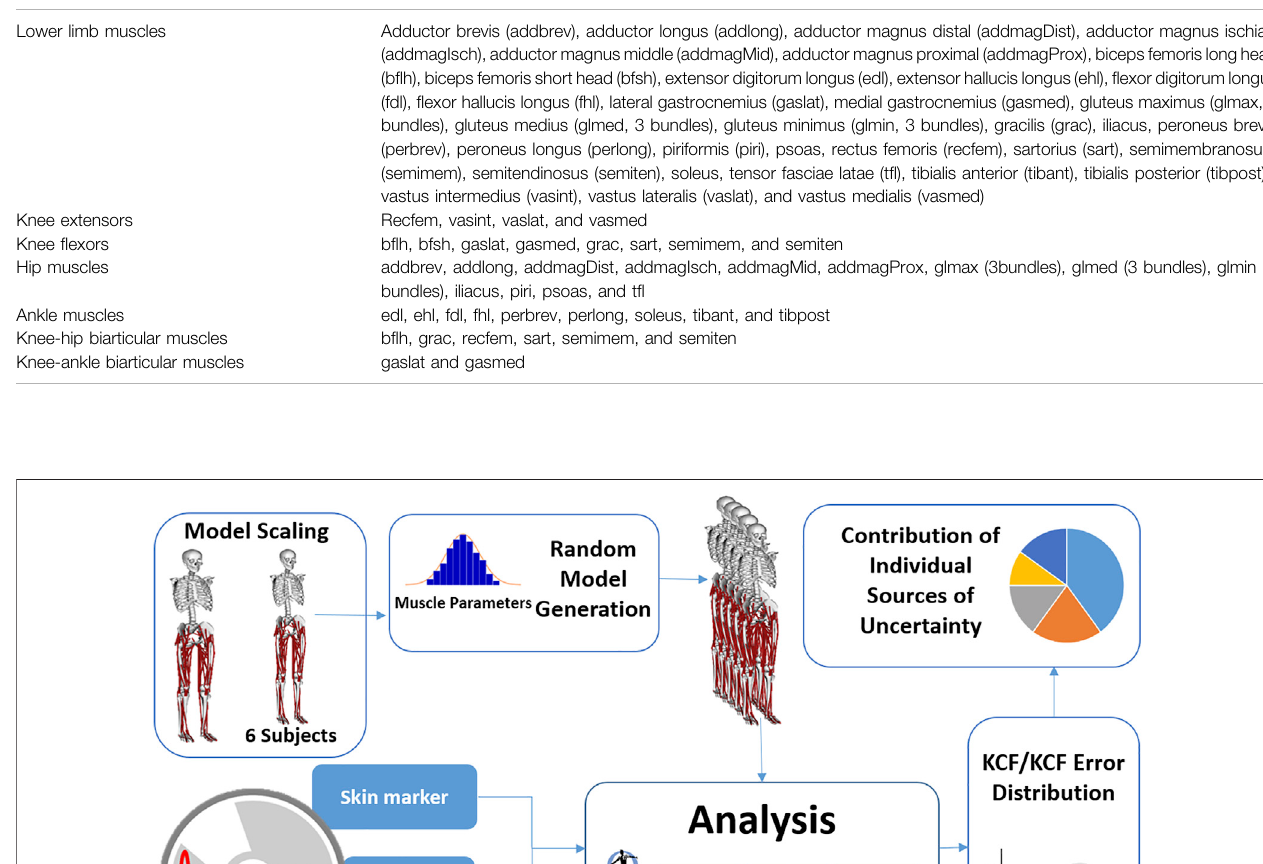
TABLE 1 | Skeletal muscle groups included in the probabilistic simulation. Muscle group Muscles in the musculoskeletal model Lower limb muscles